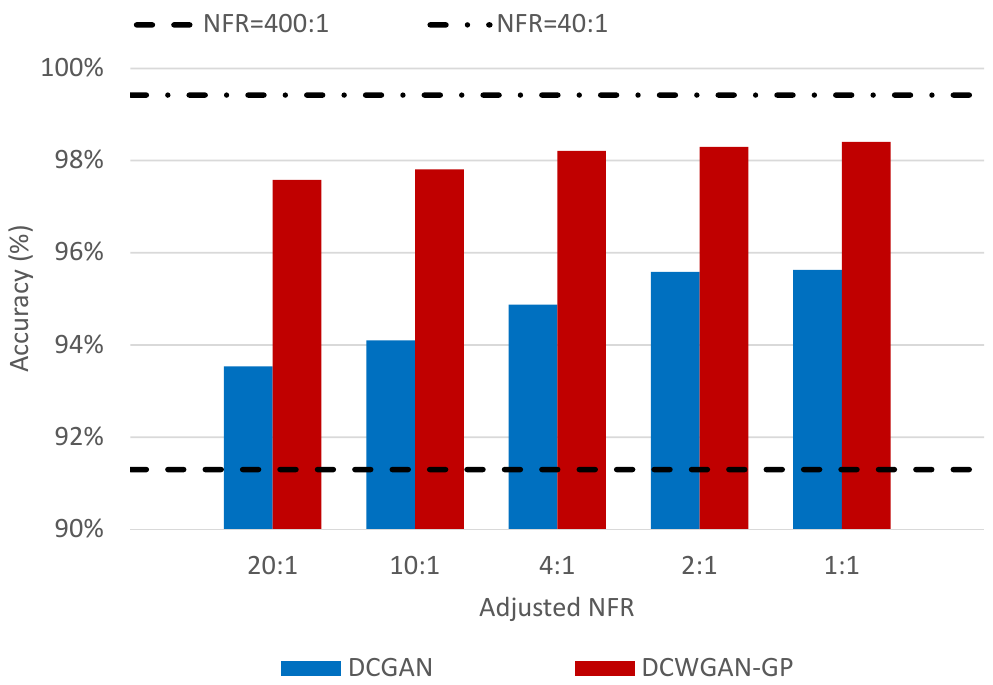
Figure 16. FDD accuracy testing:NFR = 400:1 with 20,000 normal data.